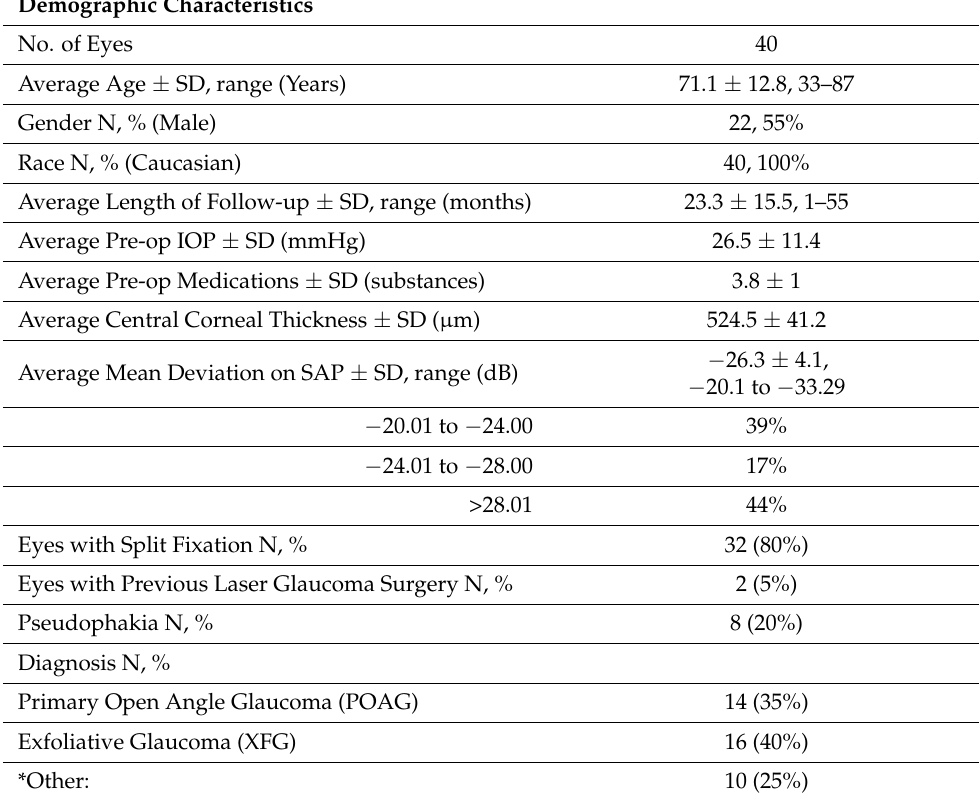
Table 1. Demographic characteristics of the cohort. POAG refers to primary open angle glaucoma and includes low tension glaucoma cases, XFG refers to exfoliative glaucoma, “*other” includes mixed mechanism glaucoma (three cases), angle closure glaucoma (two cases), pigmentary glaucoma (one case), uveitic glaucoma (one case), juvenile open angle glaucoma (one case), steroid induced glaucoma (one case) and glaucoma due to increase in episcleral venous pressure with blood in Schlemm’s canal (one case). IOP refers to intraocular pressure; SAP refers to standard automated